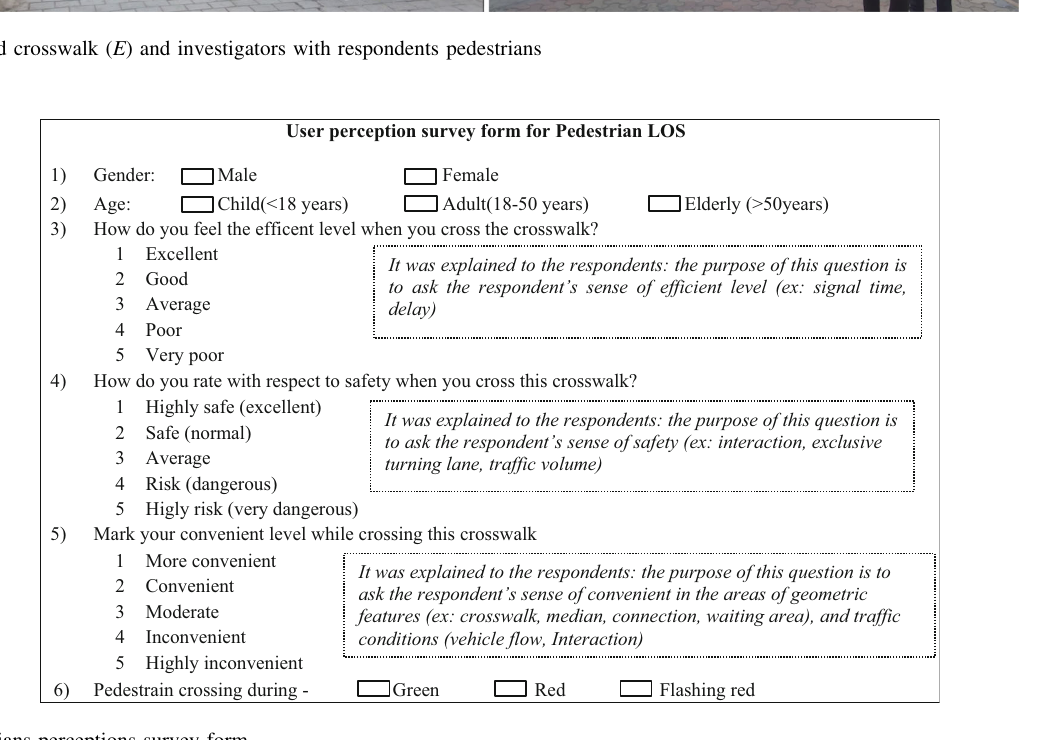
Fig. 3 Pedestrians perceptions survey